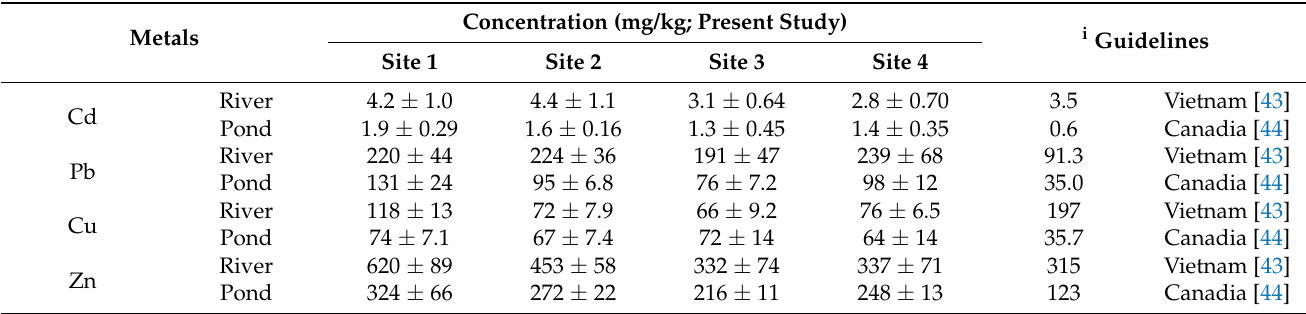
Table 1. Metal concentrations in sediment from rivers and ponds (mean ± standard error of mean) in the current study compared to Vietnamese and Canadian guideline levels